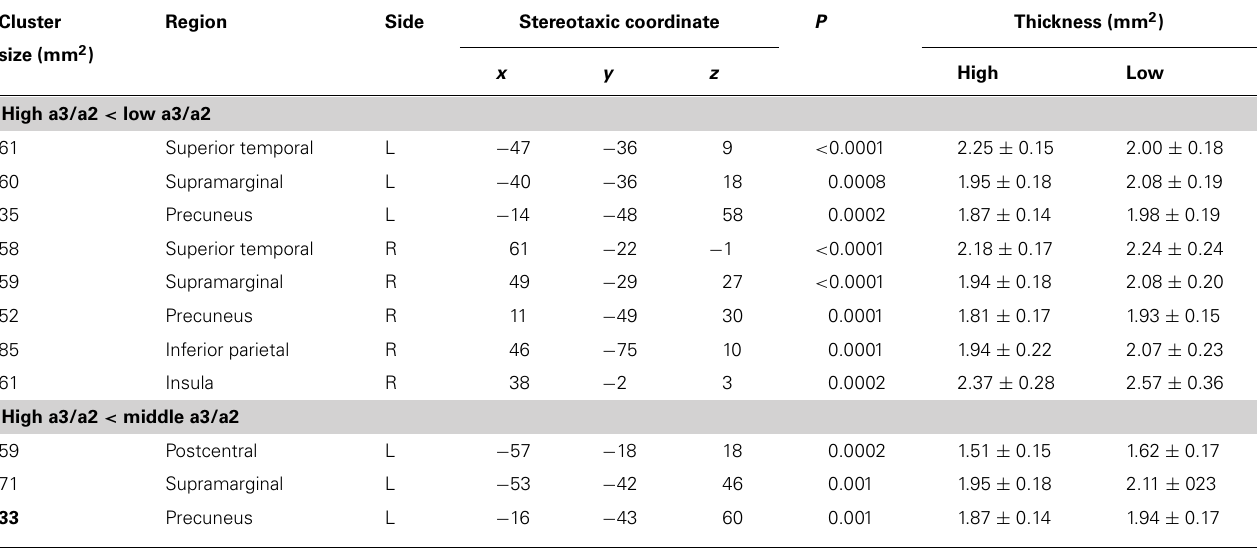
Table 2 | Brain regions with significant regional cortical thickness differences in MCI with high a3/a2 ratio compared to MCI with low a3/a2 ratio (high a3/a2 < low a3/a2) and MCI with middle a3/a2 ratio (high a3/a2 < middle a3/a2).